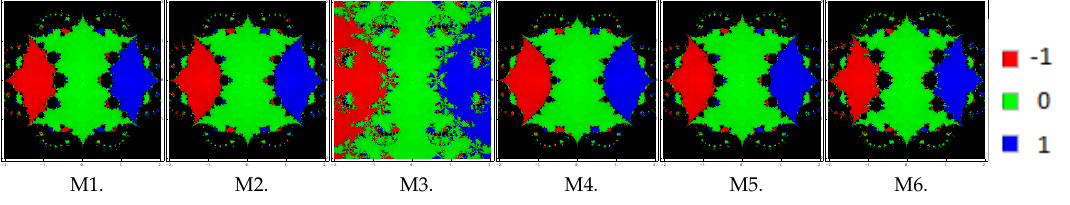
Figure 4. Basins of attraction for polynomial P 2 ( z ) for β = 10 − 2